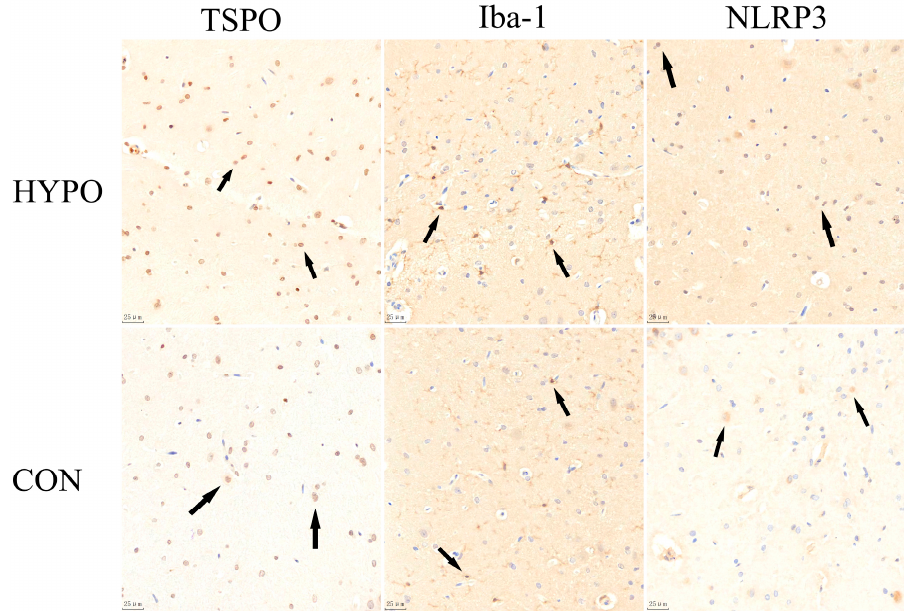
Figure 4. Typical cross-sectional rat brain images. The area indicated by the arrow is DPA-714 concentration area. ( A ) MR template for PET image standardization of rat brain (hippocampus section). 1. motor cortex, 2. retrosplenial cortex, 3. anterior hippocampus, 4. somatosensory cortex, 5. caudate putamen, 6. insular cortex, 7. thalamus, 8. hypothalamus, 9. amygdala, 10. entorhinal cortex. ( B ) Hippocampal uptake in a hypothyroid rat. ( C ) Uptake of the hippocampus at another section in a hypothyroid rat. ( D ) [ 18 F] DPA-714 images of a control rat.